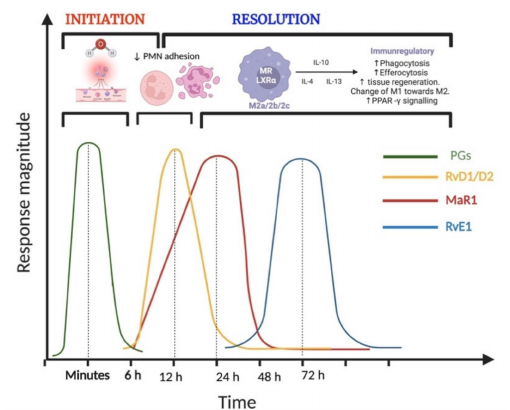
Figure 3. Early and sequential release of specialized pro-resolving mediators in acute inflammation and its resolution. SPMs play an important role in the initiation and resolution of inflammation. Resolvin D2 (RvD2) increases temporally during the transition from initiation to resolution phase with a great effect on neutrophils. Maresin 1 (MaR1) promotes macrophage switch from M1 to M2 after their marked increase. Resolvin E1 (RvE1), the most effective of the RvE-series, inhibits neutrophil migration in vitro and promotes resolution phenotype in macrophages (created with BioRender.com, accessed on 30 July